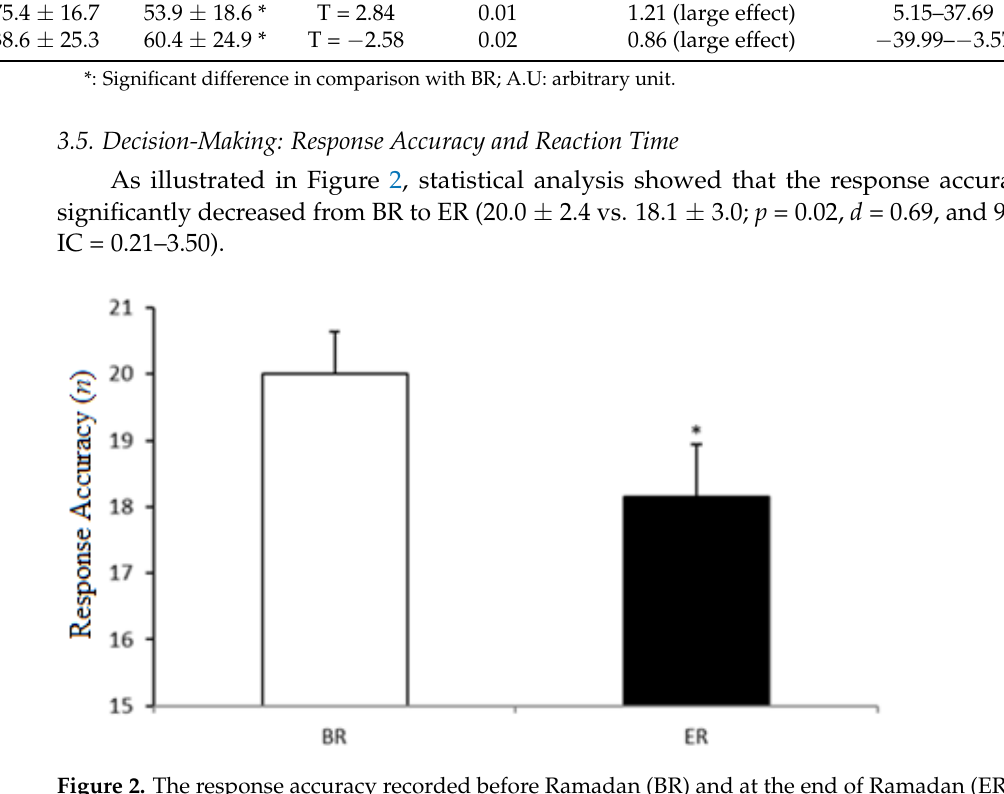
Figure 2. The response accuracy recorded before Ramadan (BR) and at the end of Ramadan (ER). *: Significant difference compared to BR.